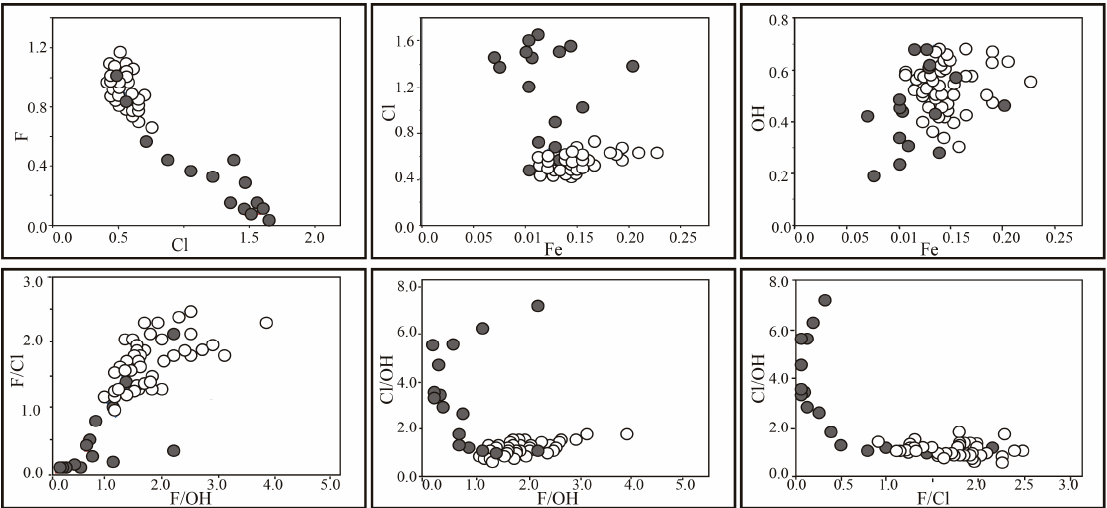
Figure 4. Apatite composition (elements ratio per formula unit; open symbols, fluorapatite; filled symbols, chlorapatite).